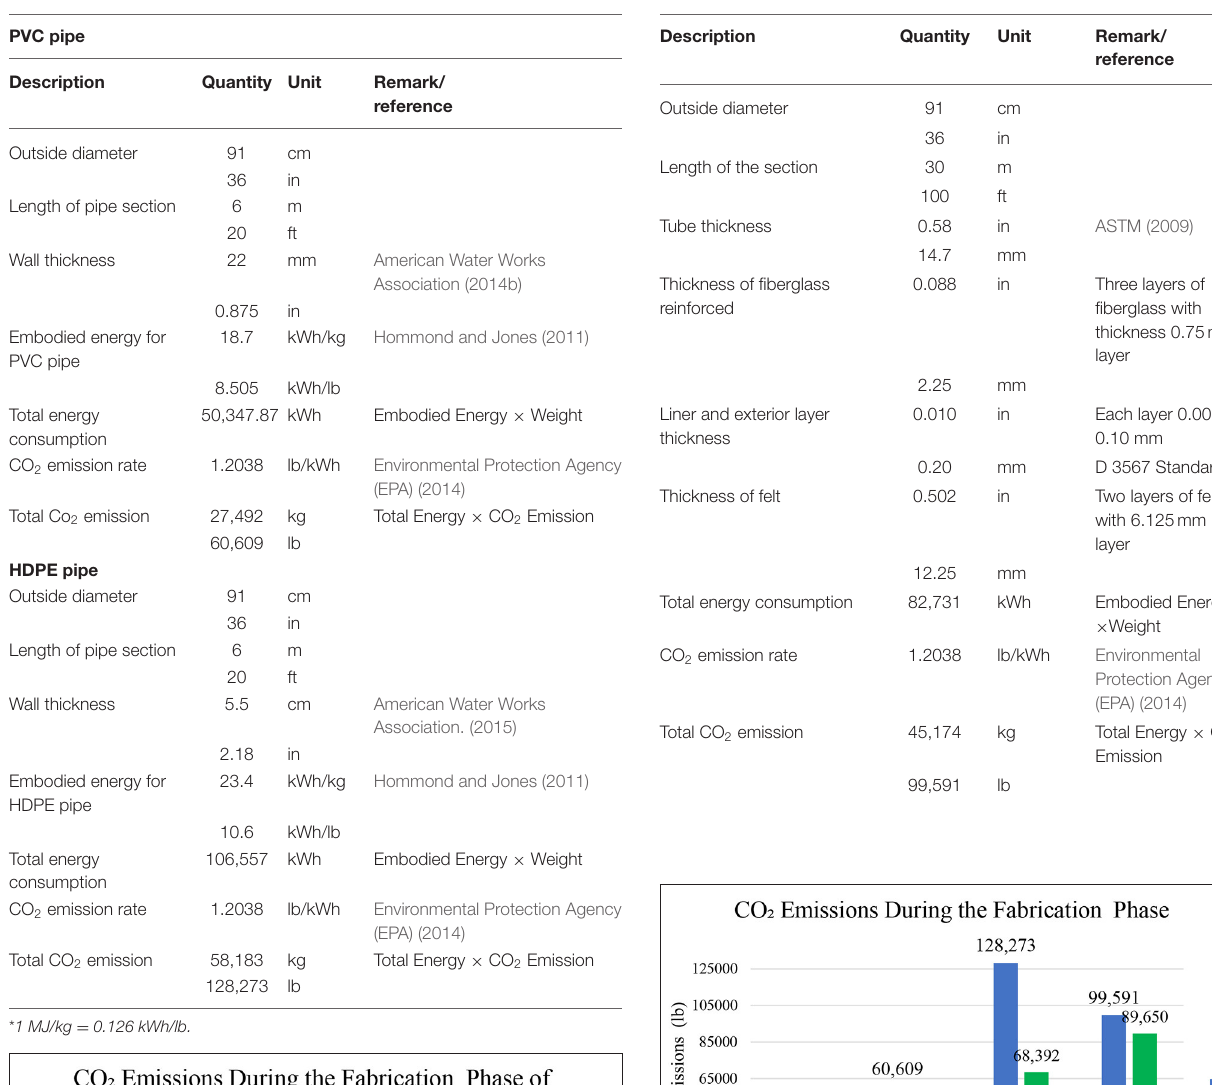
TABLE 3 | Carbon emission of CIPP Pipe.